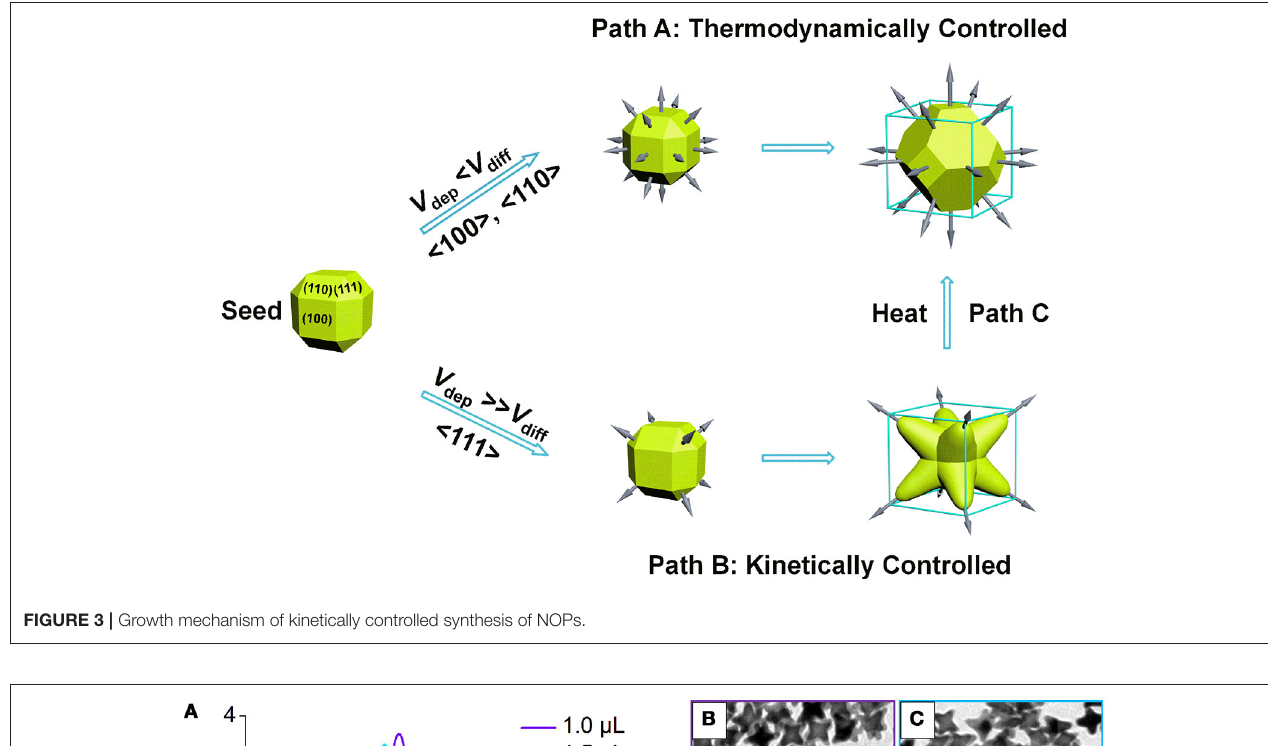
FIGURE 3 | Growth mechanism of kinetically controlled synthesis of NOPs.